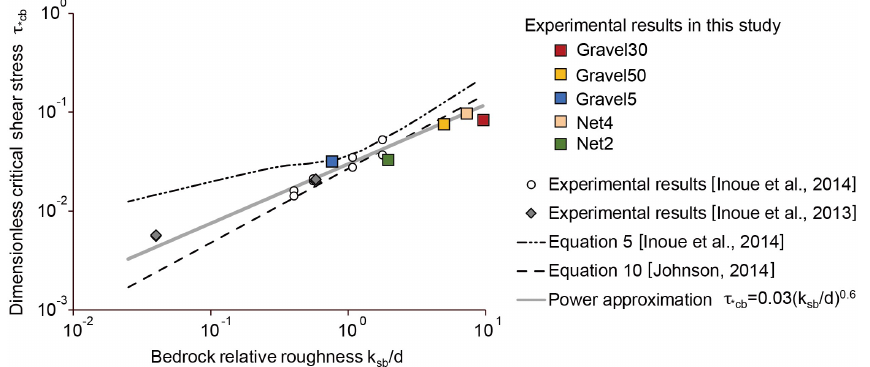
Figure 9. Relationship between relative roughness of the bedrock bed and dimensionless critical shear stress. The black squares show the results of this experiment, the white circles show the results of an investigation using the bedrock of Ishikari River in 2011 (Inoue et al., 2014), the grey rhombus represents a smooth aquifer floor (Inoue and Ito, 2013), and the grey line shows the power approximation of all the experimental results. The dotted line shows the results from Eq. (5) proposed by Inoue et al. (2014). The black double dotted lines show the results obtained by Eq. (10) (Johnson, 2014). The grain size ( d ) in the case of Inoue et al. (2013) is 5mm. Inoue et al. (2014) used gravel sized 12 and 28mm. Table 2. r br and ϕ values for comparison with the experimental